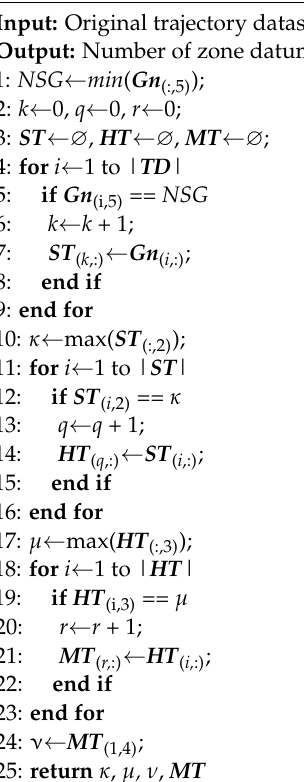
Algorithm 1: Zone benchmark grid number